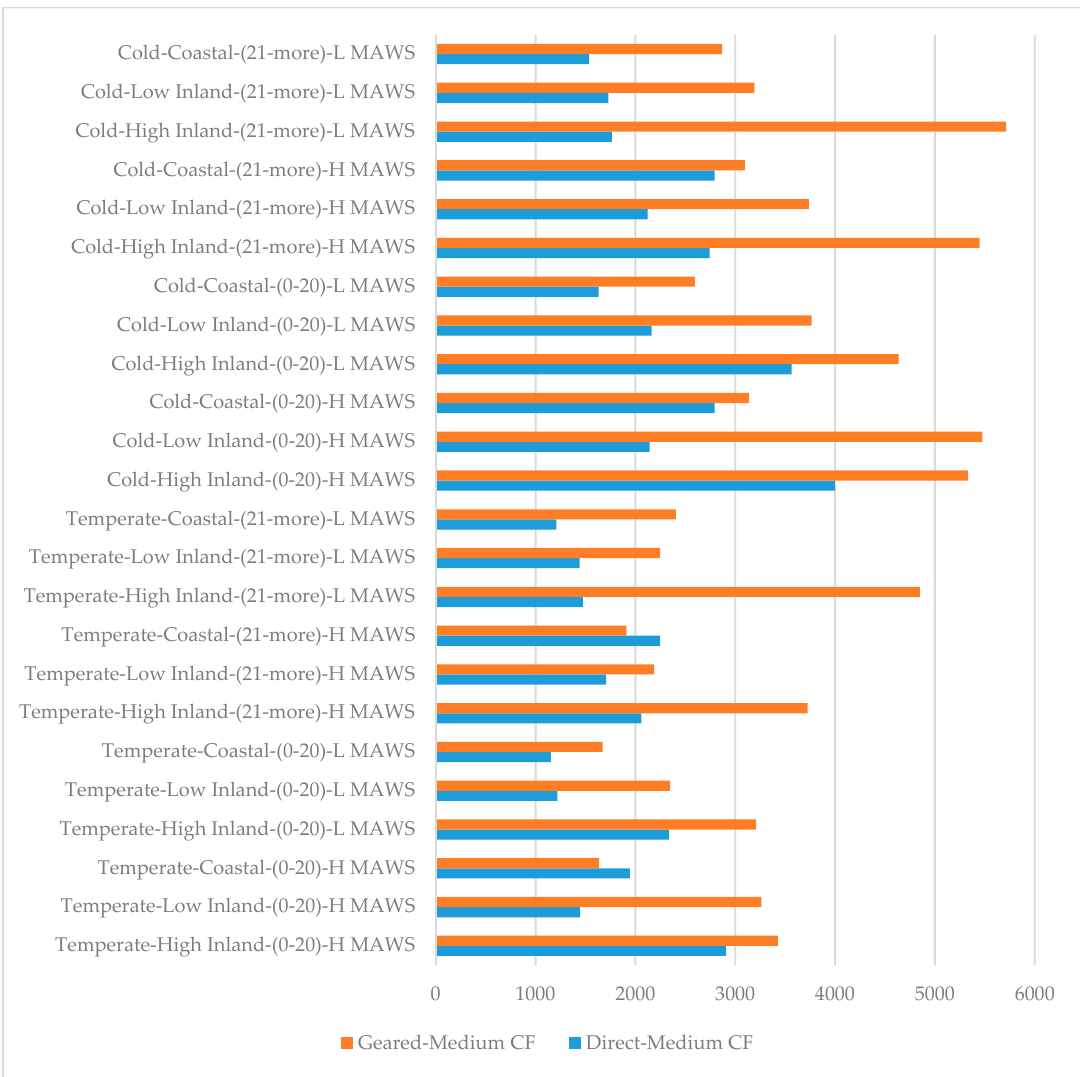
Figure 6. Predicted cost of failures at locations with medium capacity factor.